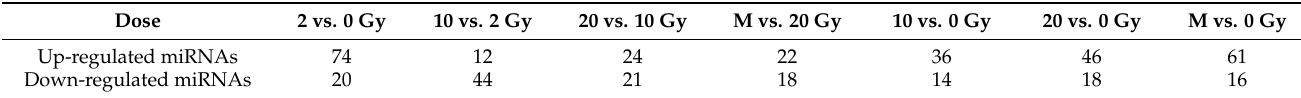
Table 2. Number of regulated miRNAs in the training set when comparing two groups using a t-test, prior to multiple correction. The numbers 0, 2, 10, and 20 represent total doses in Gy, and M is one month after end of therapy (when a total dose of 46 or 50 Gy was